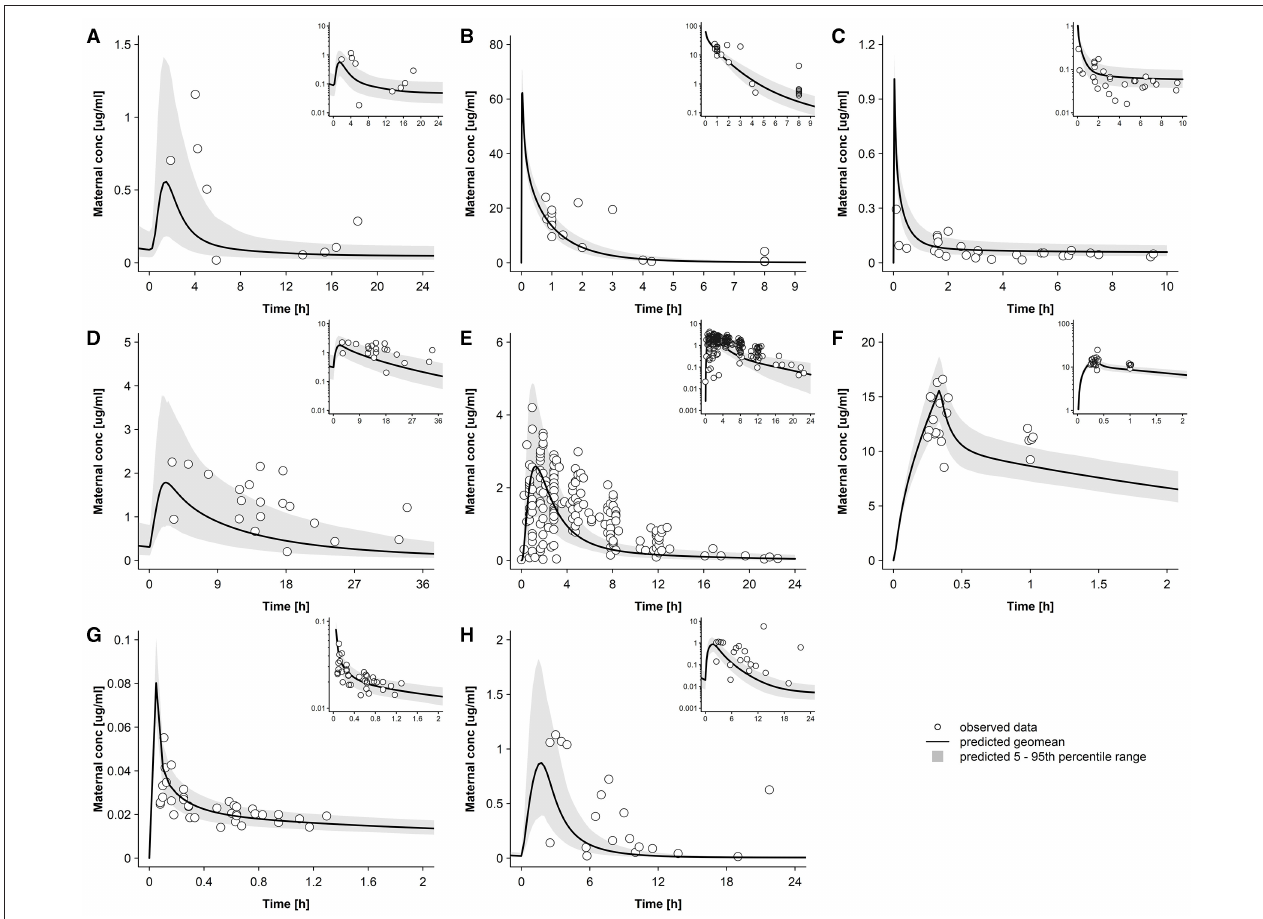
FIGURE 3 | Maternal plasma concentration–time profiles observed and predicted at delivery. Concentration-time profiles in the maternal peripheral blood plasma for acyclovir (A) , cefuroxime (B) , diazepam (C) , dolutegravir (D) , emtricitabine (E) , metronidazole (F) , ondansetron (G) , and raltegravir (H) at delivery in the third trimester. Semi-log scaled figures are shown as inset plot in the top-right corner of each panel. The time refers to the time after drug administration. Circles represent individual observed data; the solid line represents the predicted geomean and the shaded area the predicted 5th − 95th percentile range. Observed data for acyclovir, cefuroxime, diazepam, dolutegravir, emtricitabine, metronidazole, ondansetron, and raltegravir were taken from Liu et al. ( 18), Leung et al. (39), Hirt et al. (40), Philipson and Stiernstedt ( 41), De Leeuw et al. (42), Elkomy et al. (43), Visser and Hund (44), Moore and McBride (45), Ridd et al. (46), and Mandelli et al. (47), respectively. conc, concentration.